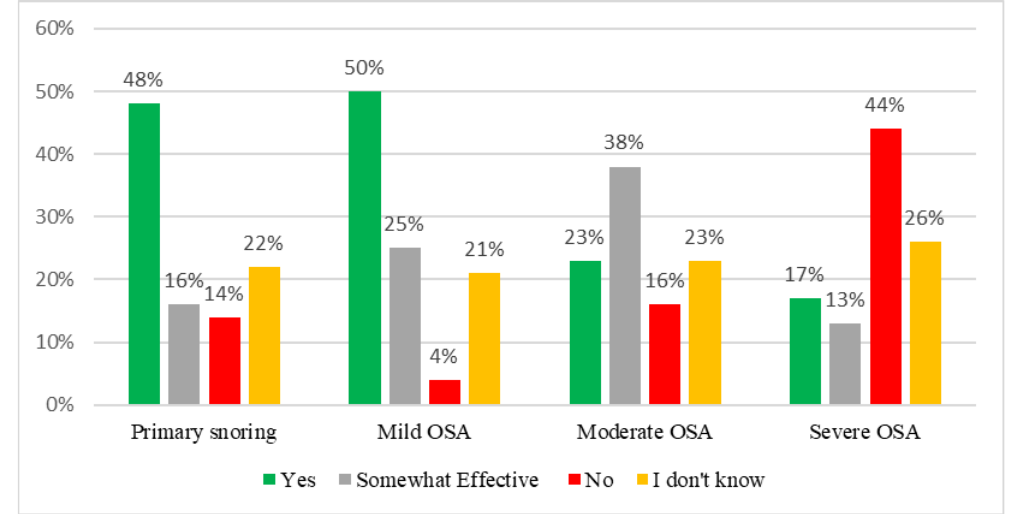
Figure 3. Physicians’ responses to their perception of the effectiveness of OAs.